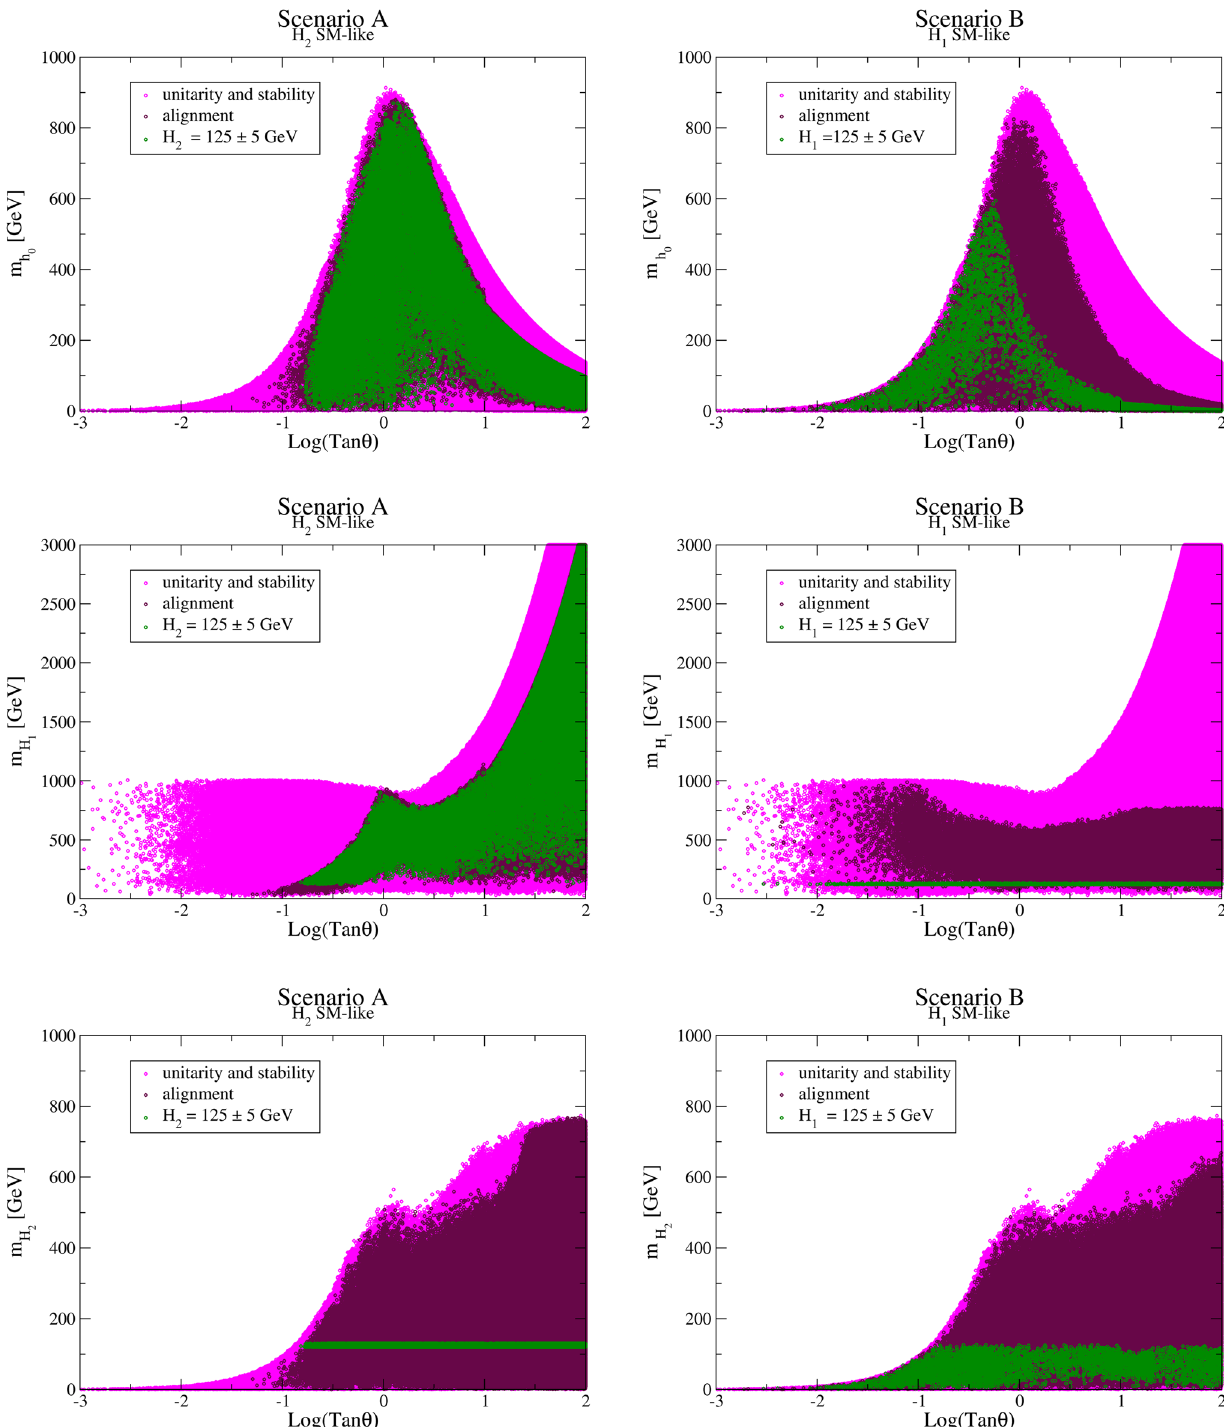
Fig. 1 Dependence of the neutral scalar masses, m h tan θ for scenario A (left) and B (right). The magenta points comply with the unitarity and stability conditions, the maroon points comply